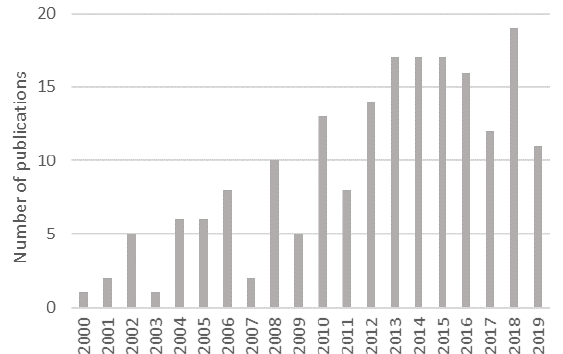
Figure 2. Publications per year on table olives that address lactic acid bacteria (LAB).